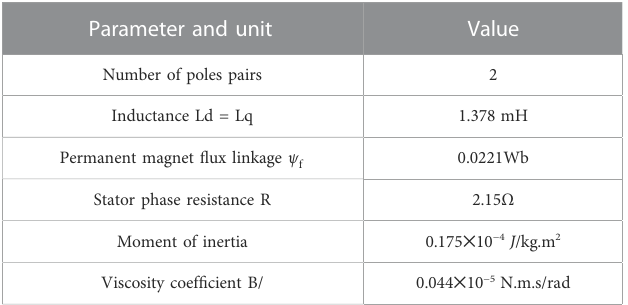
TABLE 1 Parameters of